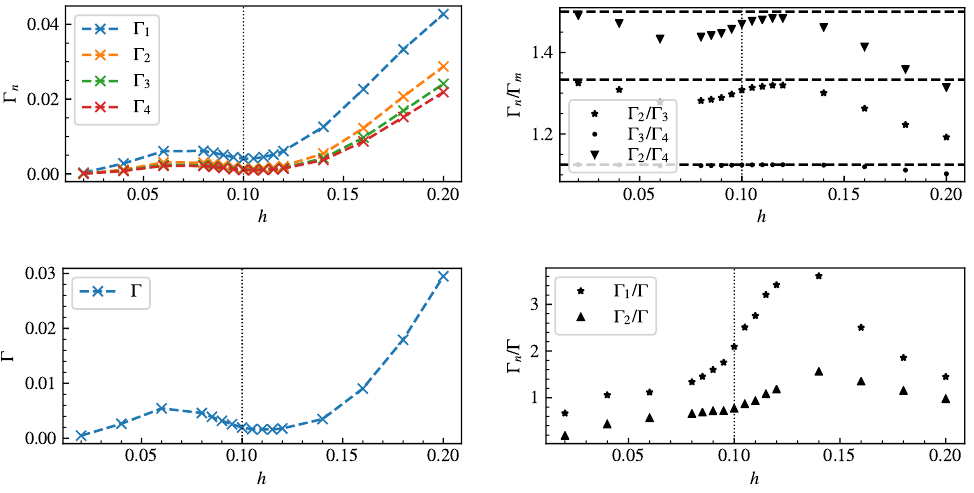
Figure B.4: Left panels: Entropy growth rates Γ (top) and magnetisation relaxation n rate Γ (bottom) in units J = 1 for longitudinal quenches in the quantum Potts spin chain starting from g = 1.25 as a function of the longitudinal coupling. Right: Ratios Γ / Γ / Γ (bottom). The dashed lines represent the universal ratios (4.4) (top) and Γ n m n that are restored in the limit h → 0. The vertical line is drawn at the value h where crit the second quasi-particle appears in the post-quench